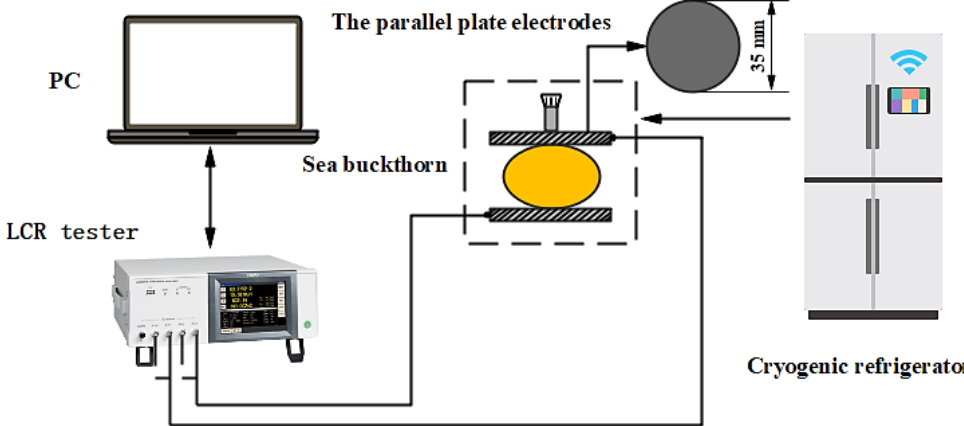
Figure 1. Experimental set up for measuring dielectric parameters of sea buckthorn.